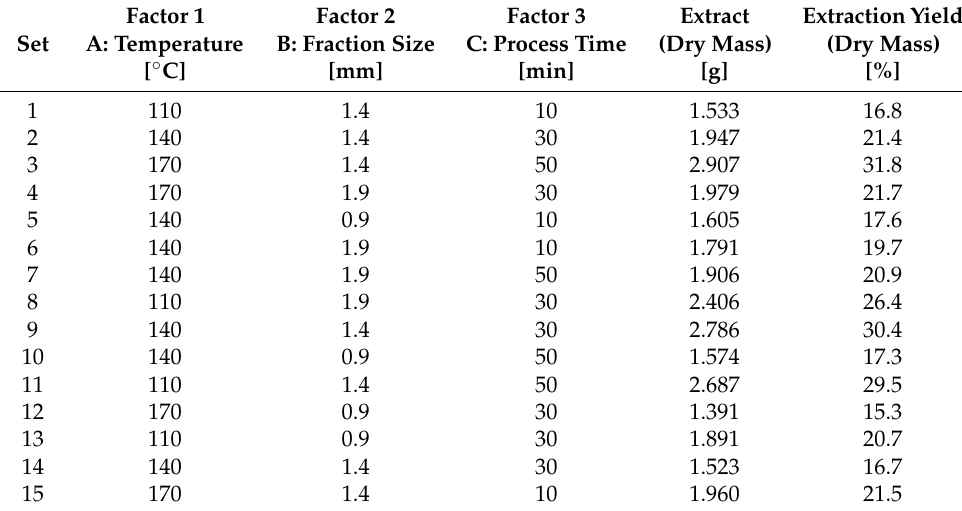
Table 3. The extraction yield in relation to dry mass of raw material.